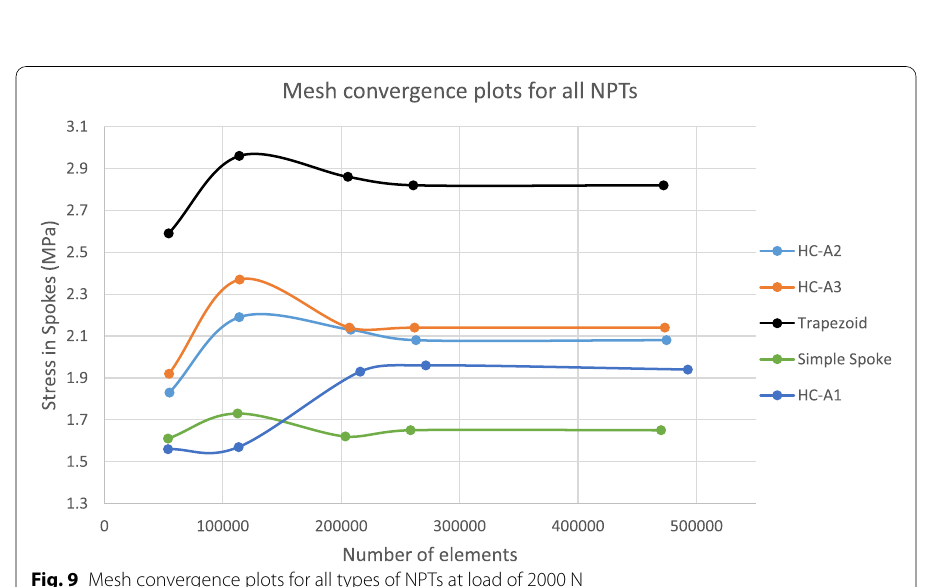
Fig. 9 Mesh convergence plots for all types of NPTs at load of 2000